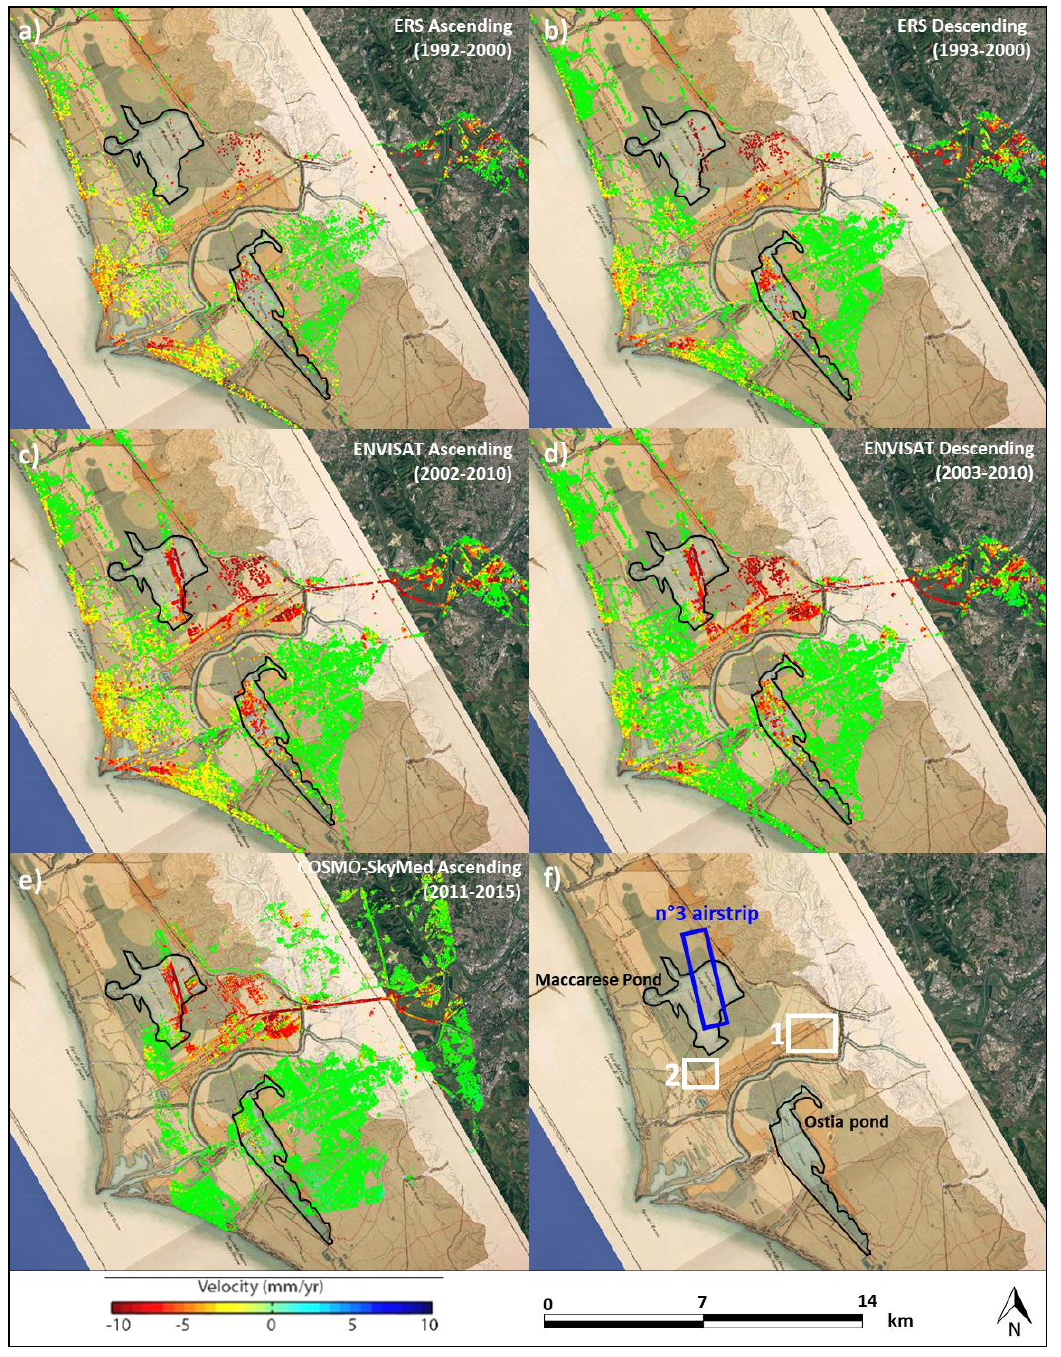
Figure 6 . A-DInSAR results plotted on the geological map by Amenduni [25]. ( a ) ERS ascending (1992 – 2000); ( b ) ERS descending (1993 – 2000); ( c ) ENVISAT ascending (2002 – 2010); ( d ) ENVISAT descending (2003 – 2010); ( e ) COSMO-SkyMed ascending (2011 – 2015); ( f ) Location of the Ostia and